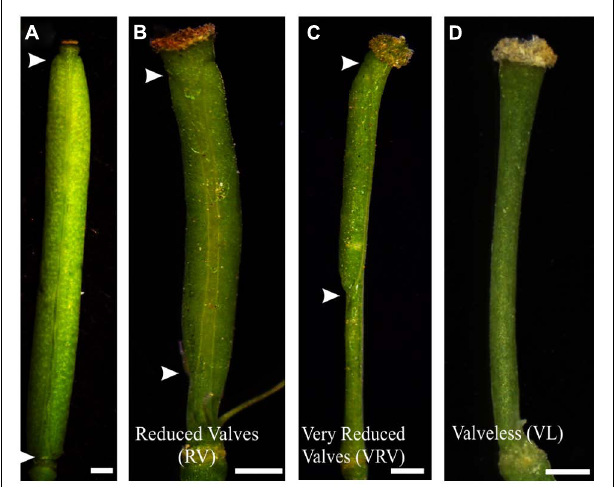
FIGURE 2 |Apical-basal phenotypes caused by exogenous BAP application. (A) Mock-treated wild type gynoecium. (B) A gynoecium with the “ReducedValves” (RV) phenotype. (C) Gynoecium with a “Very ReducedValves” (VRV) phenotype. (D) Gynoecium with the “Valveless” (VL) phenotype.The arrowheads indicate the beginning and the end of valves. Scale bars: (A) 1 mm; (B,C) 400 μ m; (D) 200 μ